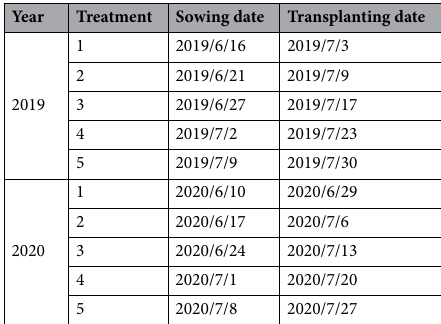
Table 6. Sowing and transplanting date of different treatments from 2019 to 2020.